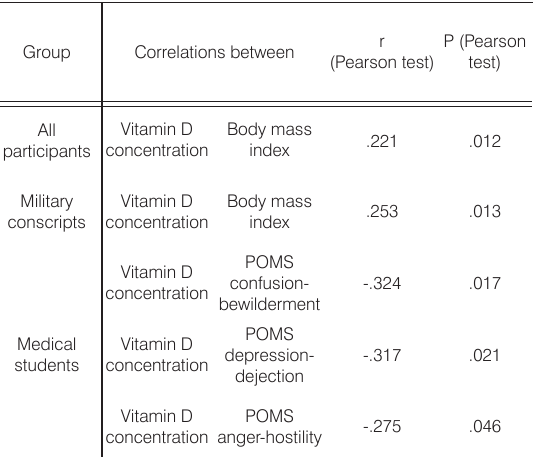
Group Correlations